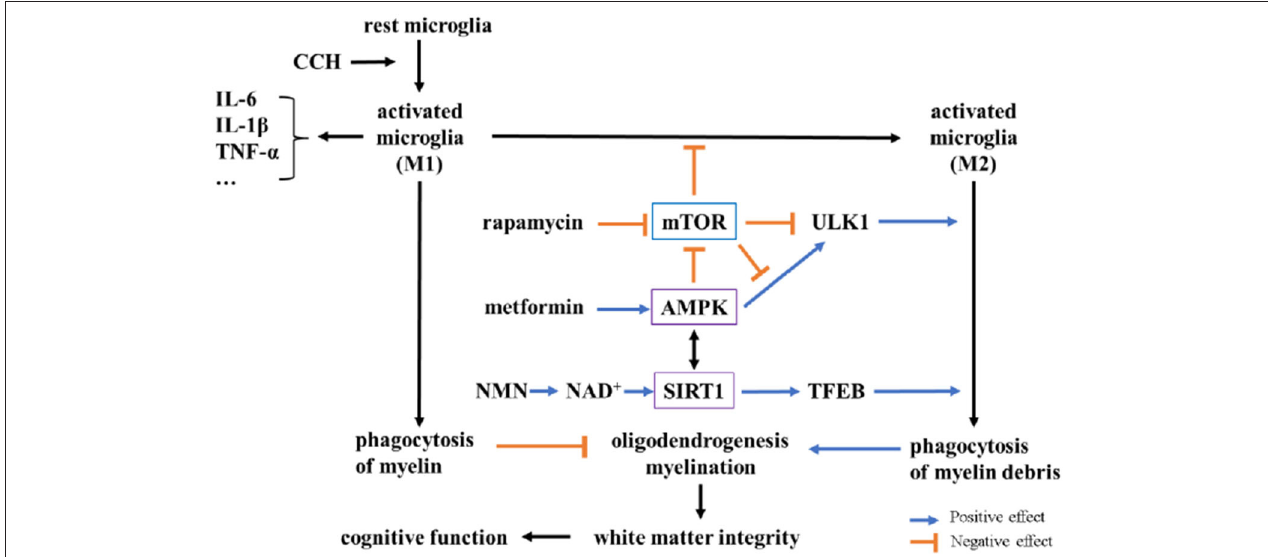
FIGURE 6 | Potential mechanisms underlying neuroprotection of metformin, rapamycin, and NMN after BCCAO in rats. In chronic cerebral hypoperfusion (CCH) rats, activated microglia (M1) increase and destroy white matter integrity by releasing pro-inflammatory factors (like IL-6, IL-1 β ) and inhibiting oligodendrogenesis and myelination via microglial phagocytosis. Metformin and NMN could activate AMP-activated protein kinase (AMPK) and Sirtuin 1 (SIRT1), respectively. Rapamycin inhibits mTOR to increase M2 microglial polarization. AMPK and SIRT1 could also inhibit M1 polarization by decreasing the expression of NF- κ B, as well as promoting M2 polarization. The activation of AMPK and the inhibition of mTOR could promote phagocytosis via the phosphorylation of ULK1, while SIRT1 could promote phagocytosis through deacetylation of transcription factor EB (TFEB). There is a complex interplay among AMPK, mTOR, and